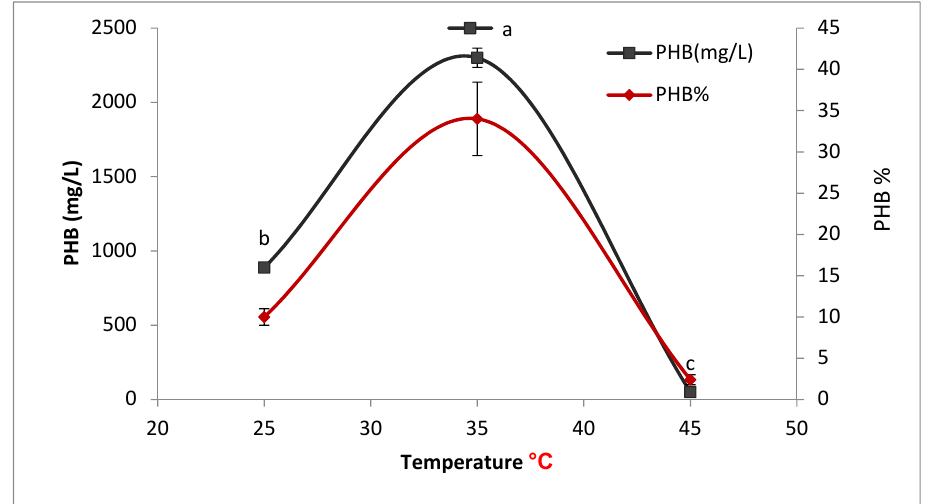
Figure 8. Effect of temperature on the production of polyhydroxybutyrate (PHB) by Bacillus wiedmannii strain. The ANOVA test was carried out by using SPSS 21 comparisons among means ± SE standard error ( n = 3); different letters show significance at p = 0.05 level based on Duncan’s multiple range test.